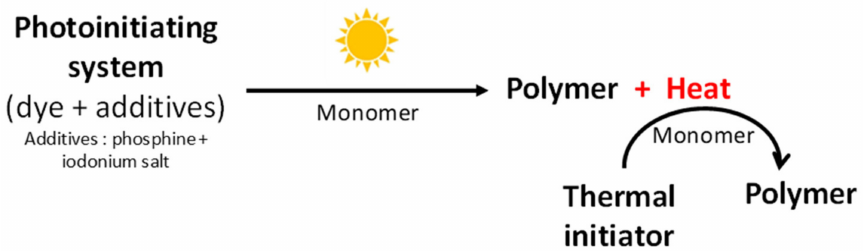
Figure 2. Orthogonal approach between thermal initiation vs.